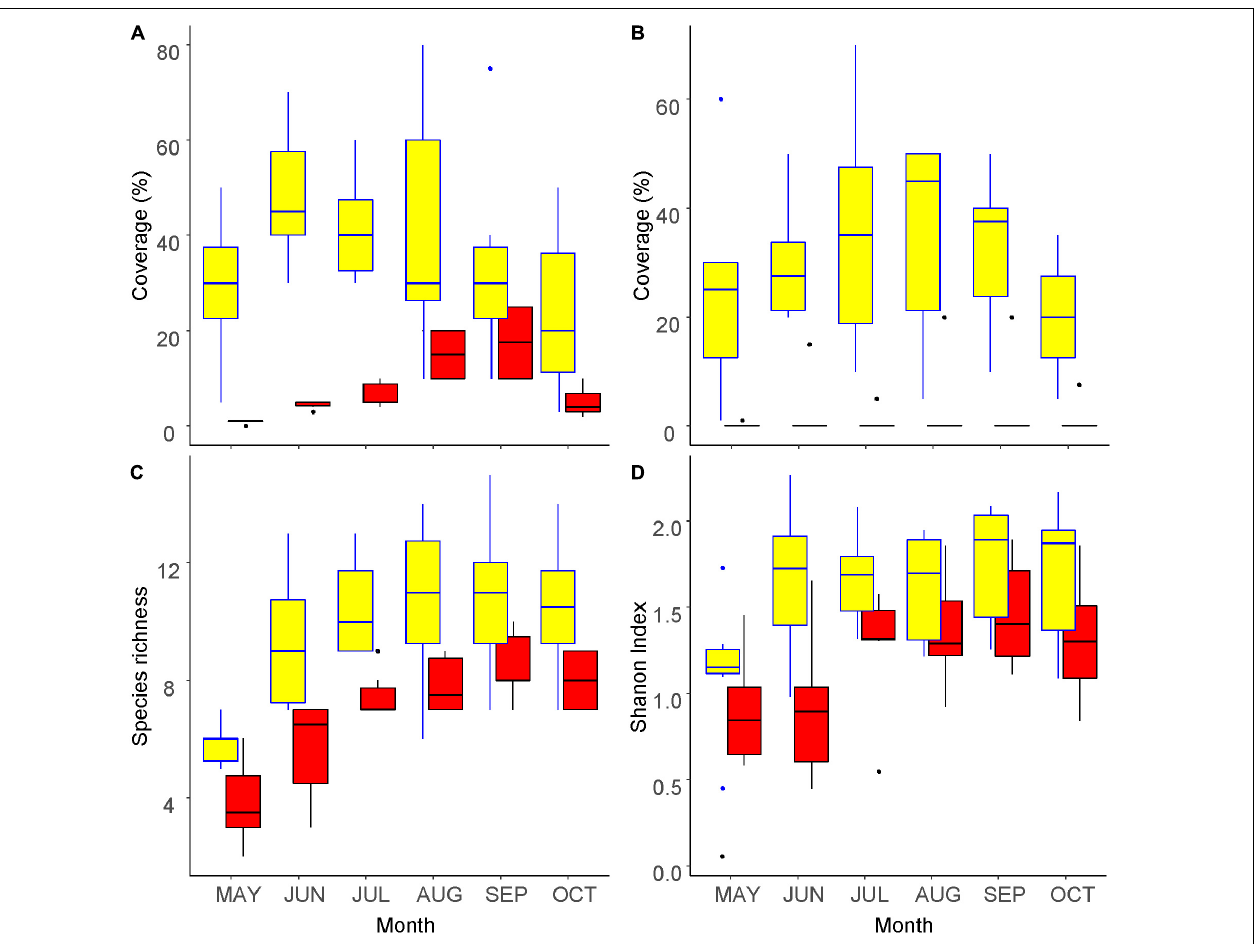
FIGURE 1 | Seasonal changes in vegetation inside (yellow) and outside (red) of the exclosure fence at the Zelkova serrata plantation in the University of Tokyo Chichibu Forest. (A) Percentage of vegetation coverage at 0–30 cm above ground level. (B) Percentage of vegetation coverage at 100–150 cm above ground level. (C) Number of species. (D) Shannon